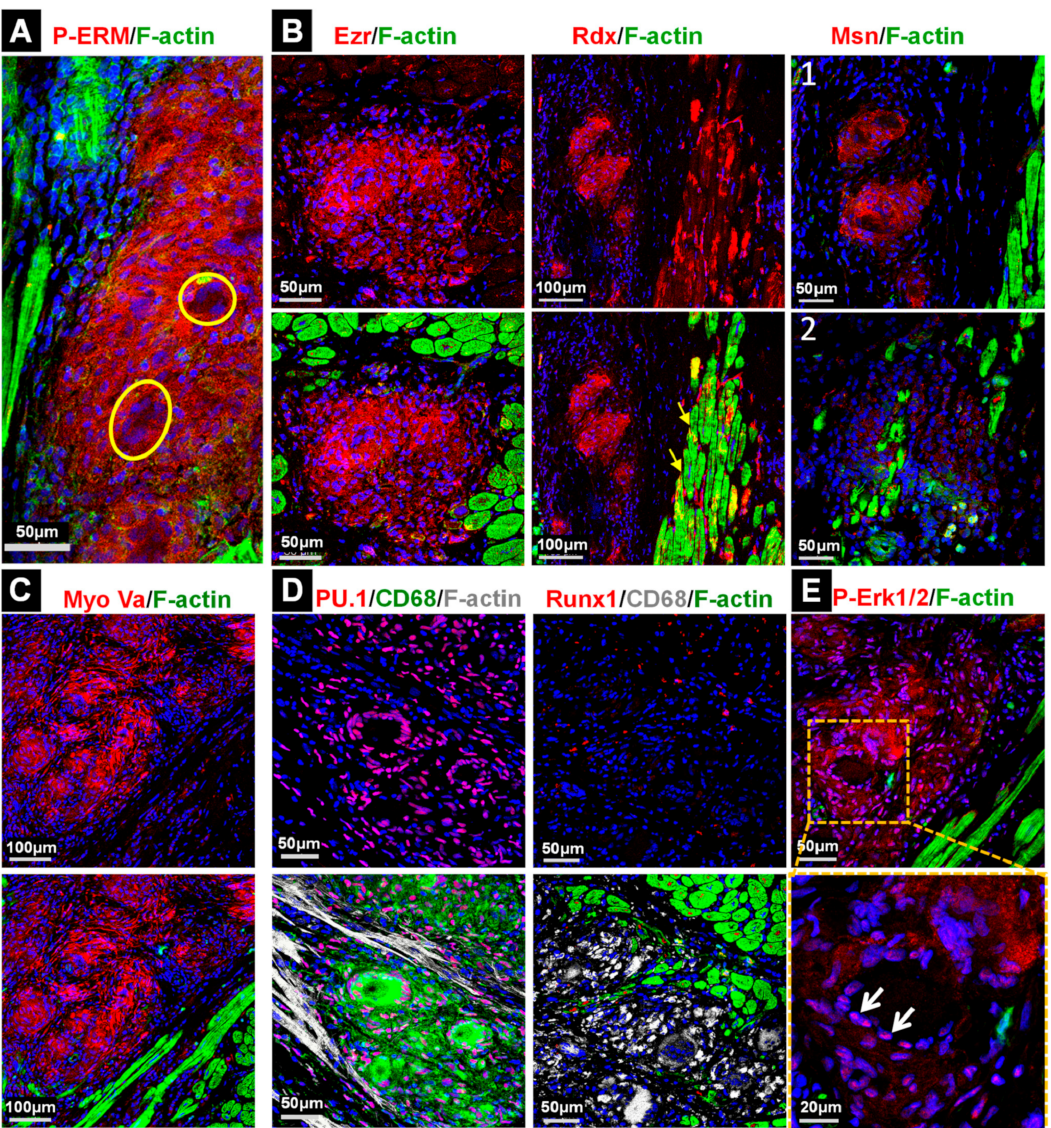
Figure 3. ERM (ezrin, radixin and moesin) proteins are strongly expressed and activated in granulomata (P-ERM). ( A ) P-ERM staining identifies highly activated GL. Giant cells are negative for P-ERM (yellow circles in enlarged images). ( B ) Ezrin (Ezr) reveals strong staining but radixin (Rdx) is also clearly present in GL. Moesin (Msn) shows various signal intensities indicating different qualities of granulomata (white 1 vs. white 2). Note the relocalization of radixin at the intercalated disc of cardiomyocytes (yellow arrows). ( C ) The molecular motor protein myosin Va is strongly expressed in granuloma. ( D ) Nuclear localization of the transcription factor PU.1 in macrophages is clearly visible but Runx1 appears to be absent. Note that the utilized antibody can recognize Run2 and 3. ( E ) Strong phosphorylation (P-Erk1/2) and nuclear localization (white arrows) of Erk1/2, as shown in the enlarged image, indicates activated macrophages. The nuclei are stained blue with